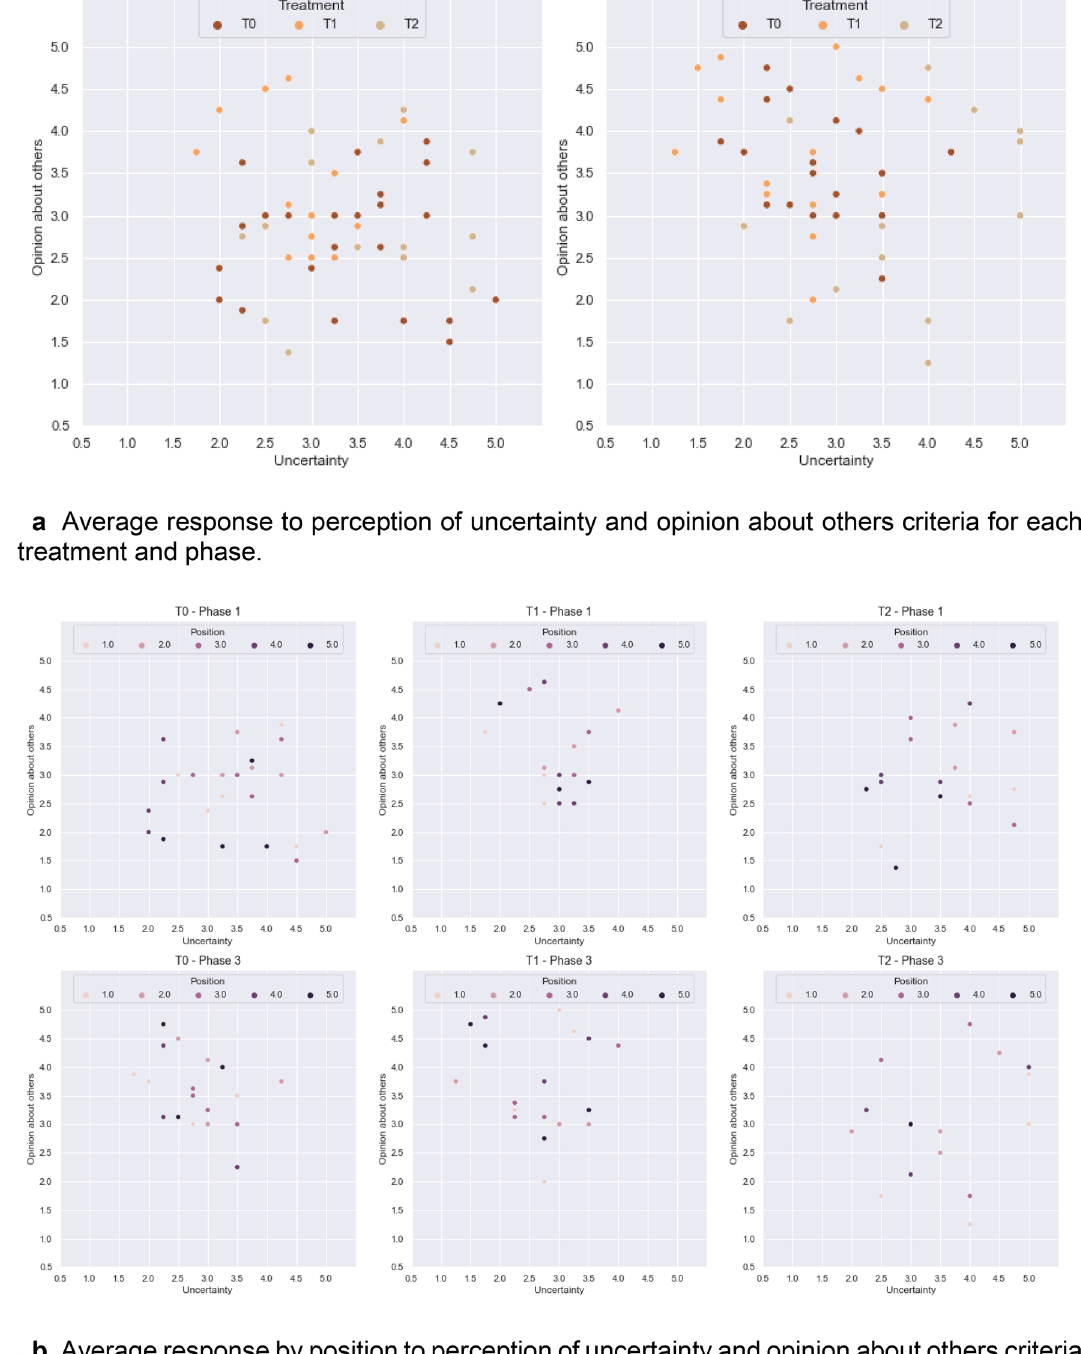
Figure 4. Average response to perception of uncertainty and opinion about